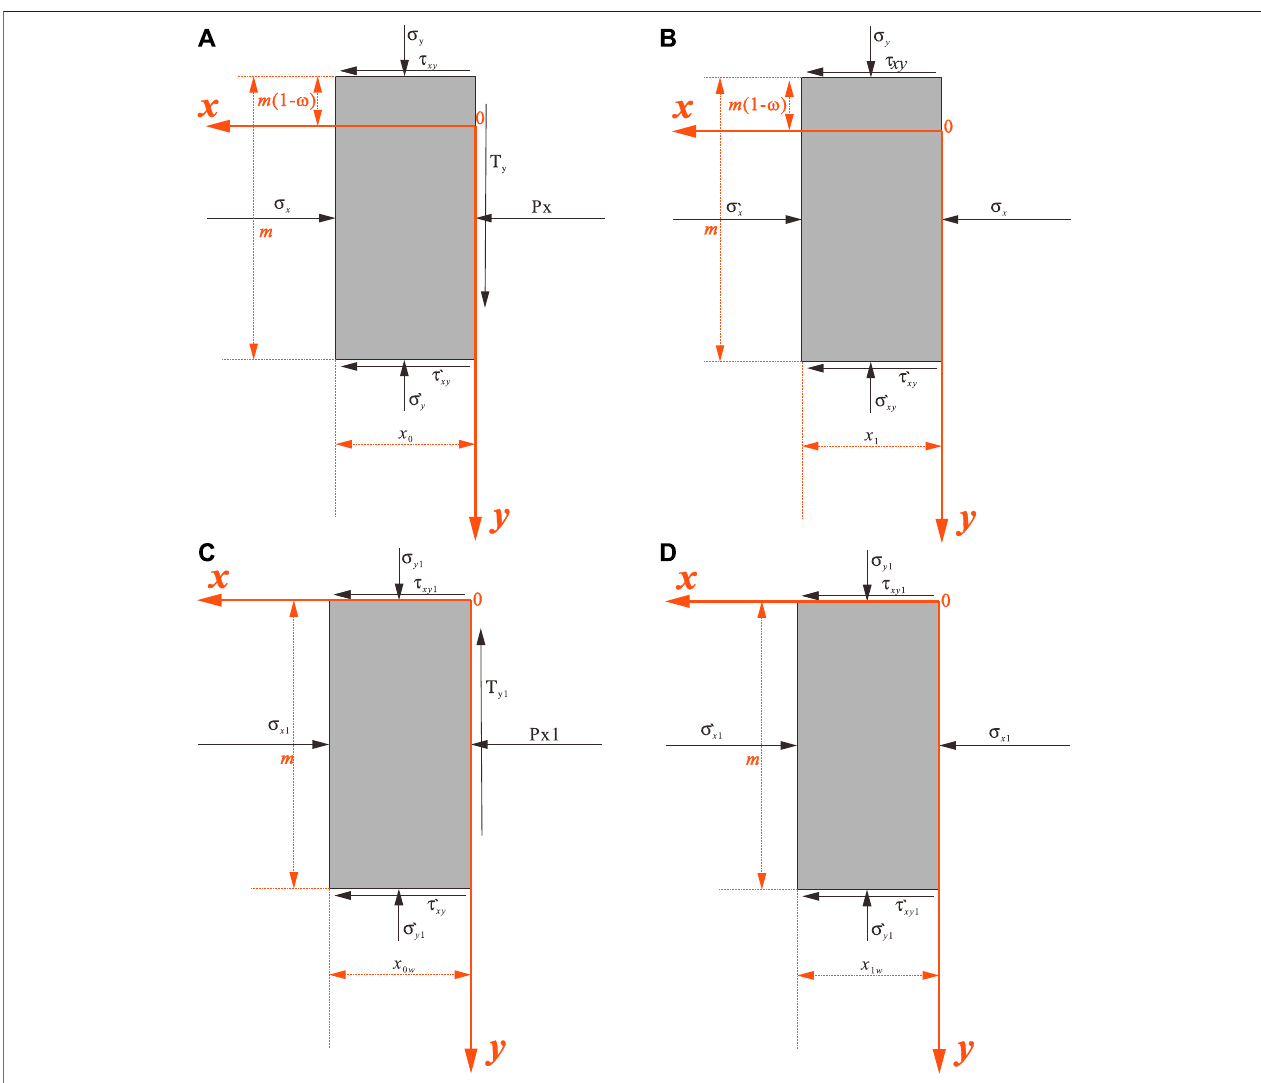
FIGURE 4 | Calculation model for highwall mining with back fi ll under the fi lling condition (single-side goaf model). (A) Calculation model for plastic- fl ow zone in highwall mining with back fi ll under the incomplete fi lling condition. (B) Calculation model for plastic-softening zone in highwall mining with back fi ll under the incomplete fi llingcondition. (C) Calculationmodelforplastic- fl owzoneofhighwall miningwithback fi llunderthecomplete fi llingcondition. (D) Calculationmodelforplastic-softening zone of highwall mining with back fi ll under the complete fi lling condition.